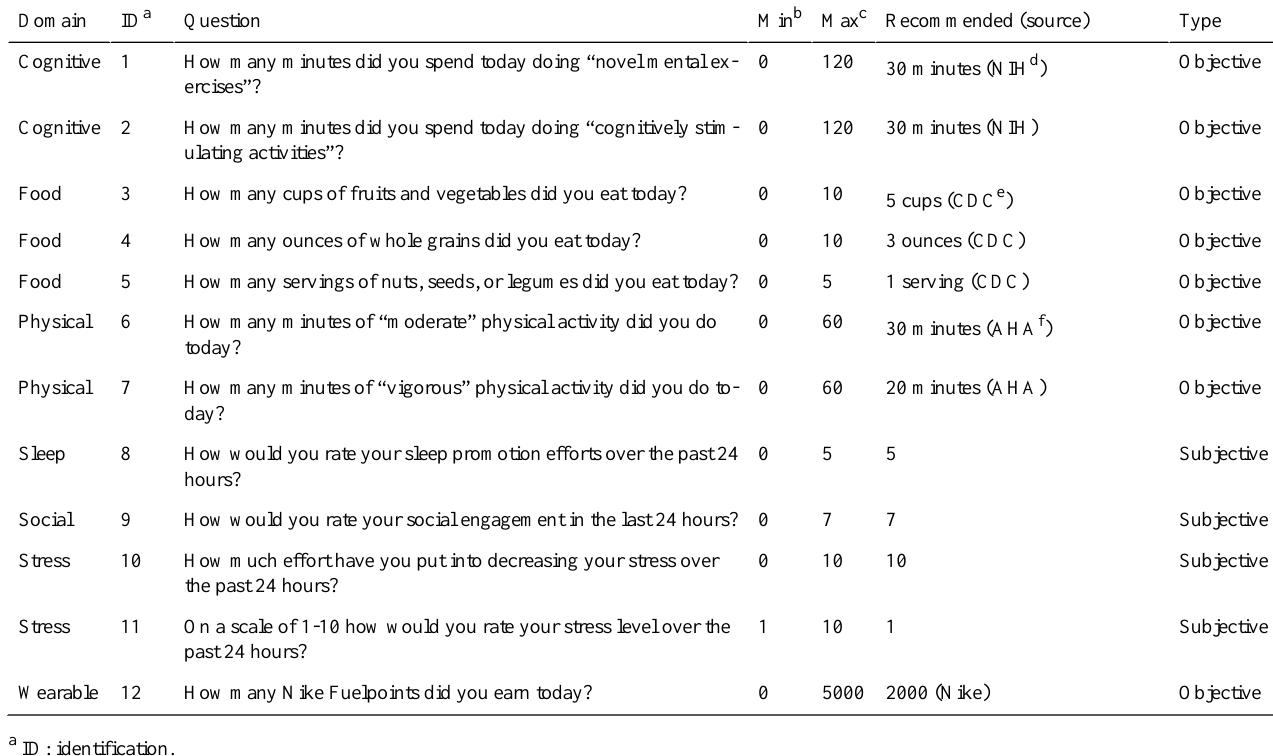
Table 1. The questions presented to the user, showing their minimum, maximum, and recommended values.